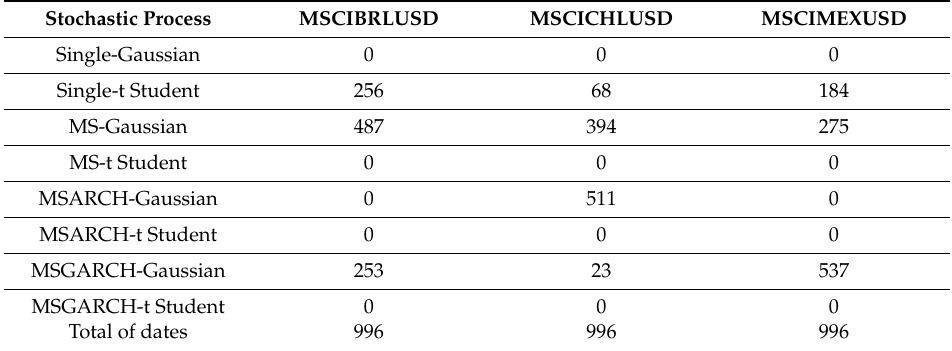
MSGARCH-Gaussian 253 Total of dates 996 996 996 Source: own calculations with data of Thomson Reuters